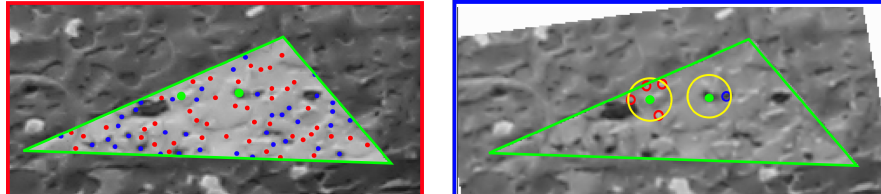
Figure 12. The search region (yellow circle in secondary image ROI-right) and potentially matching points (same characteristic point: max (red), min (blue)) correspond with considered interest point in the master image (left-green). The green triangle frame is ROI